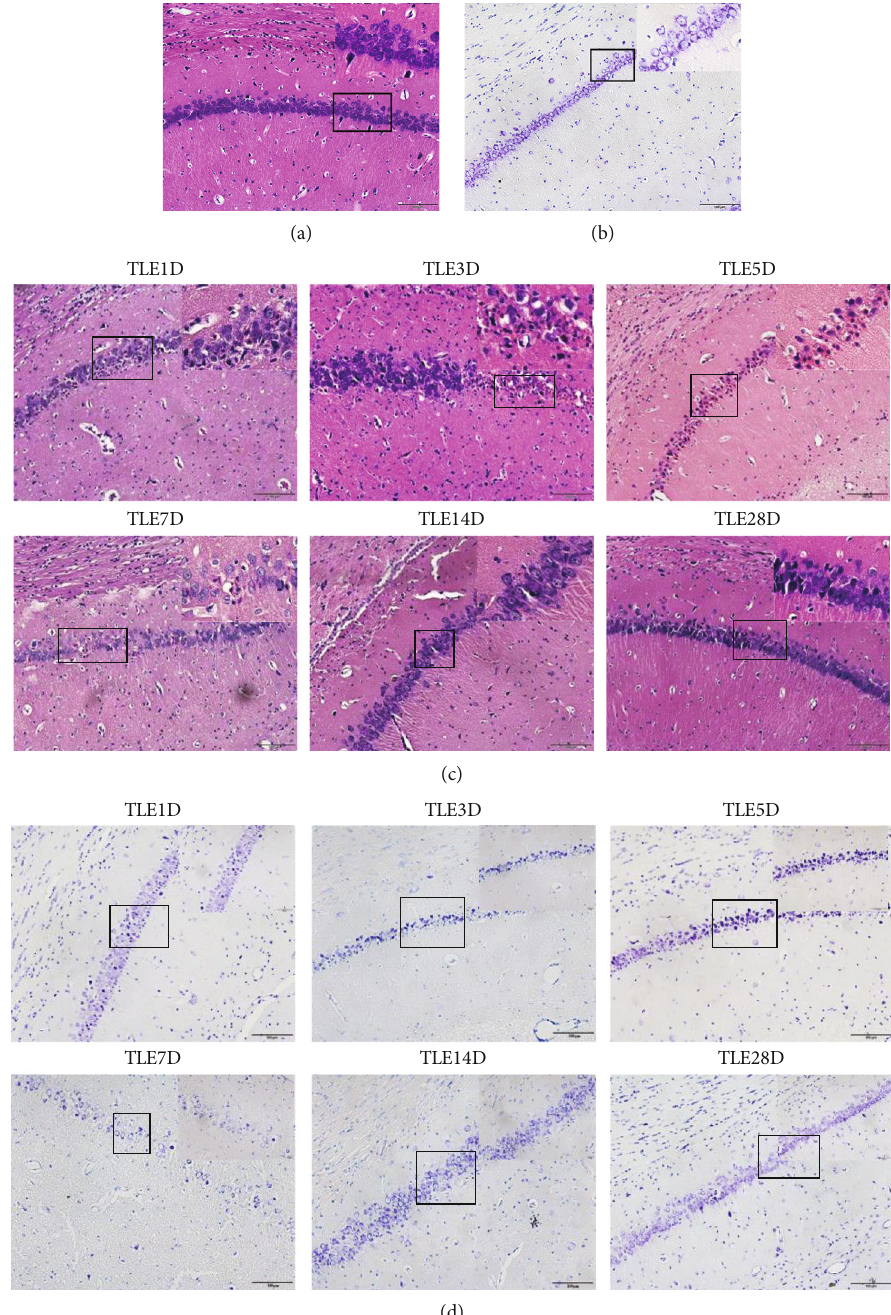
Figure 4: Neuronal damages in hippocampus of TLE rats. (a) Representative images of the histological outcomes in the normal group evaluated with H&E staining. Bar, 100 μ m. (b) Representative images of the histological outcomes in the normal group evaluated with Nissl staining. Bar, 100 μ m. (c) Representative images of histopathological outcomes in the TLE group evaluated with H&E staining. Bar, 100 μ m. (d) Representative images of histopathological outcomes in the TLE group evaluated with Nissl staining. Bar, 100 μ